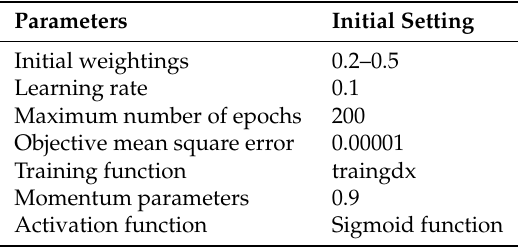
Table 2. Initial settings for the parameters in the ANN